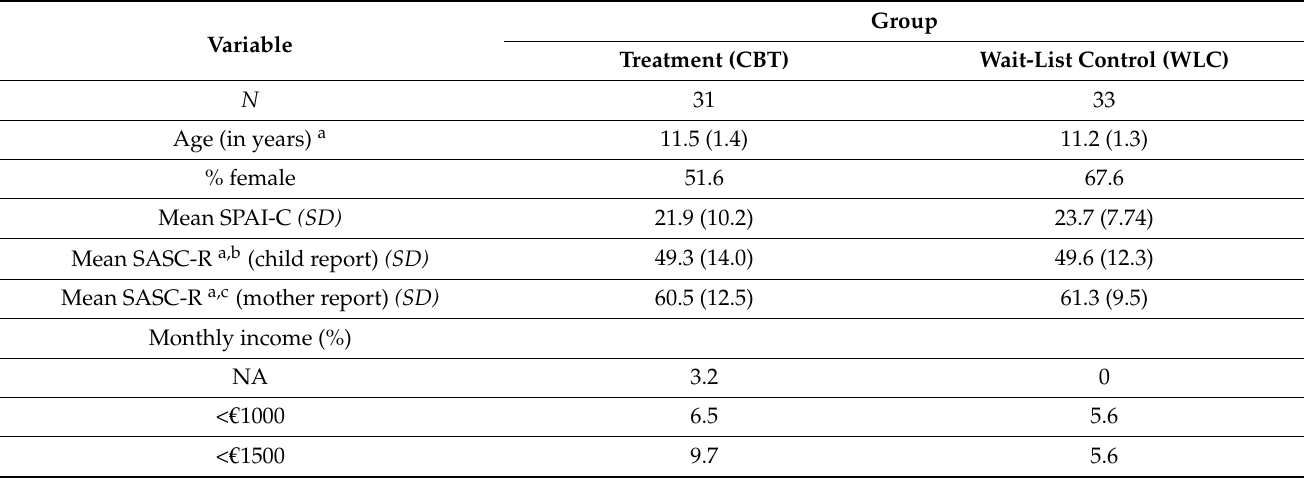
Table 2. Participant Characteristics: Treatment Versus Wait-List Control